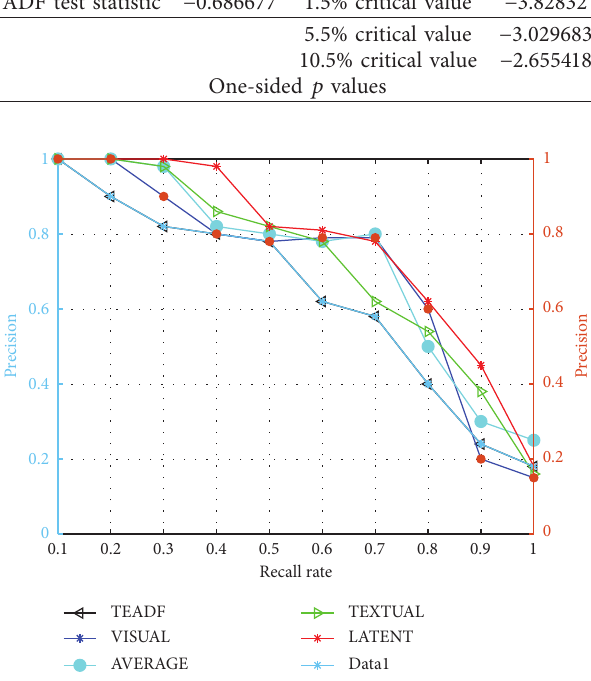
Figure 8: Precision and recall curves of all methods. Table 4: The recall rate and precision rate of the detection subset of user operation behavior.